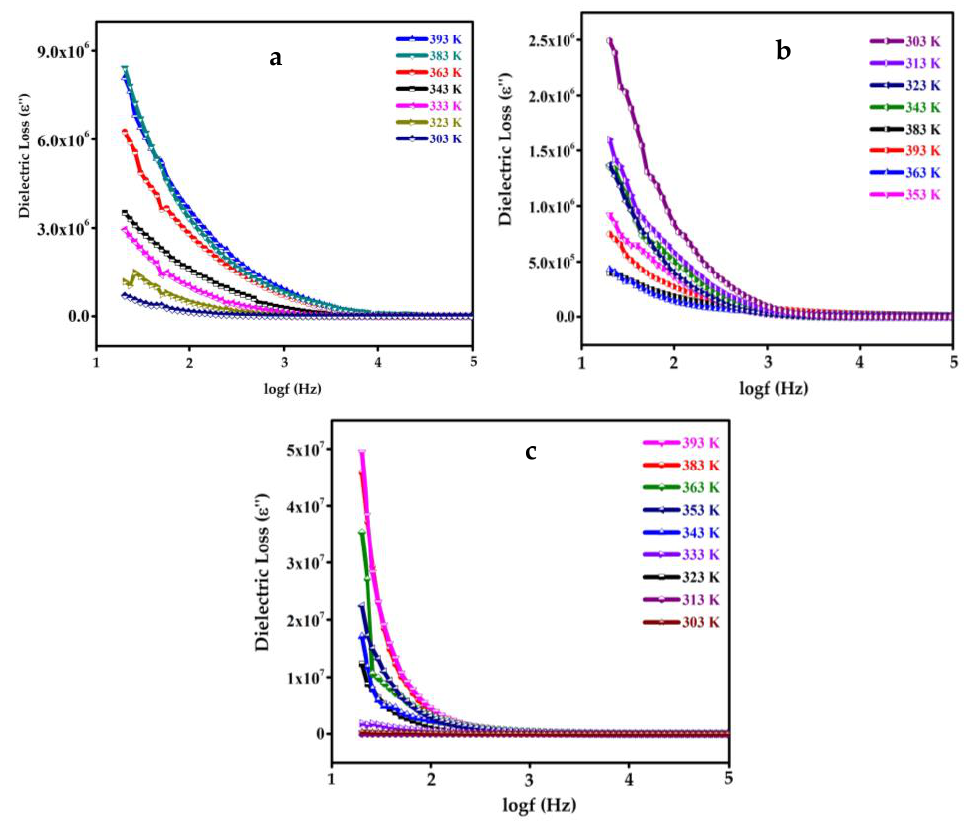
Figure 11. Dielectric loss ( ε”) variation with frequency at different temperatures for ( a ) SnO 2 QDs, ( b ) GO, and ( c ) SGP2 composite film.